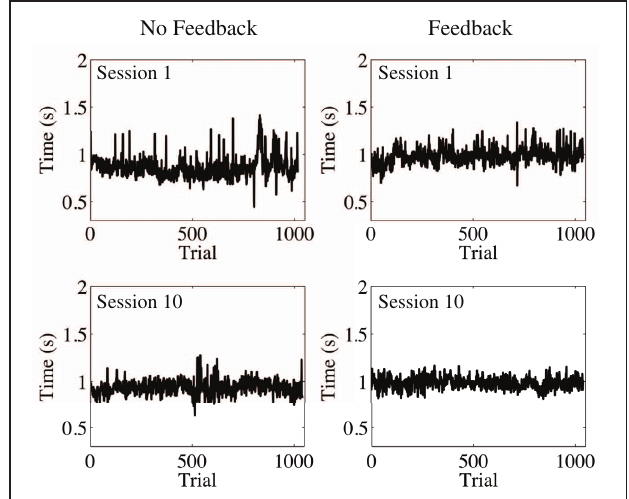
FIGURE 6 | Trial series of continuous time estimates with and without accuracy feedback after removing observations faster than 300ms and beyond 3 SD from the mean. The participant performed the task 10 times in each feedback